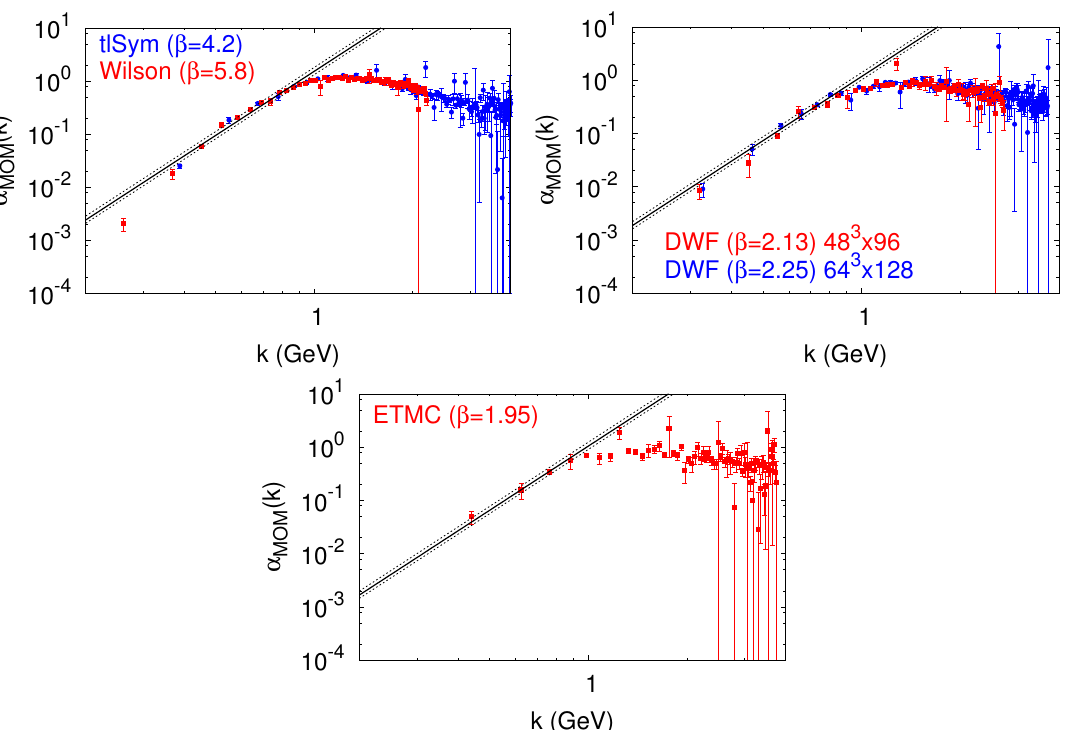
Figure 6 . (Color online) (cid:11) MOM vs the momenta obtained from quenched gauge con(cid:12)gurations (lefmost upper panel), N f = 2 + 1 Domain-Wall (rightmost upper) and ETMC N f = 2 + 1 + 1 (lower). The (cid:12)t to the instanton prediction is represented by the straight